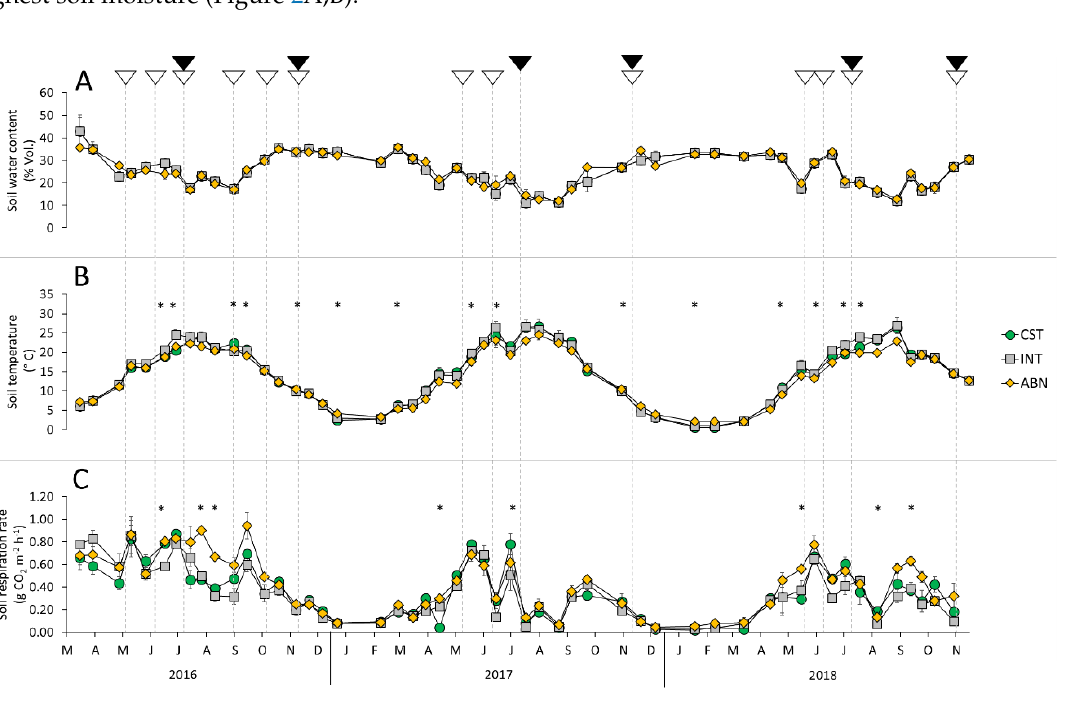
Figure 2. Seasonal variations of the soil water content ( A , 10 cm depth), soil temperature ( B , 10 cm depth), and soil respiration ( C ) during the study period from April 2016 to November 2018. Black triangles, dates of the mowing applied for customary management (CST); white triangles, dates of the mowing applied for intensive use (INT); no mowing was applied for abandonment (ABN). Vertical bars, standard errors. Data are means of three replicates per treatment. *, p < 0.05. Table 1. Repeated measure ANOVA for soil water content, temperature, and respiration during the growing periods (G) and the vegetative stasis (S) for customary management (CST), intensive use (INT), and abandonment (ABN). Different letters indicate significant differences (Tukey HSD test, p < 0.05).